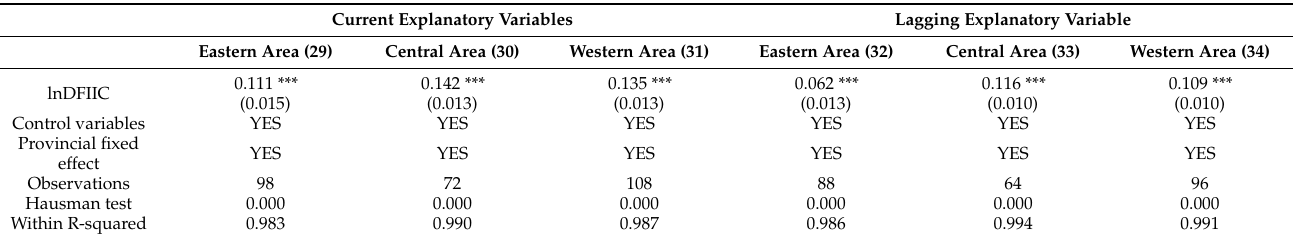
Table 7. Regional heterogeneous